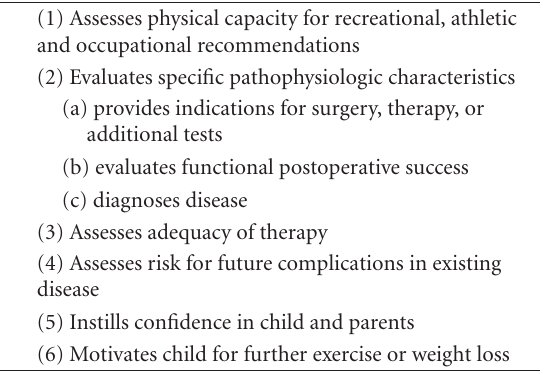
Table 1: Indications for exercise testing in